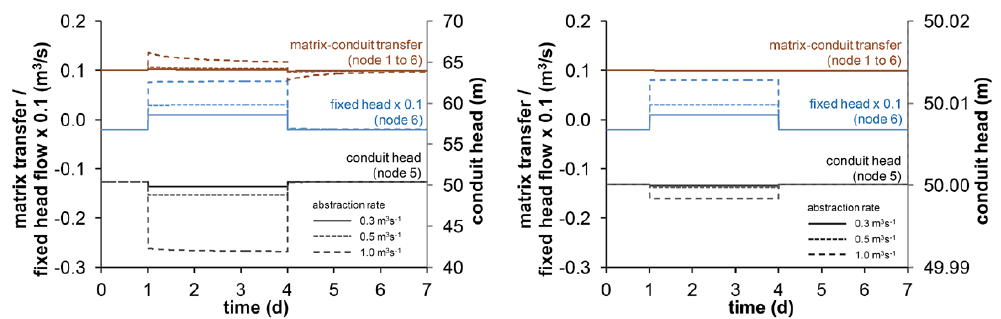
Fig. 6. Simulation results for the basic model (without CADS): conduit head at the pumping well, flow at the conduit constant-head boundary condition (here multiplied by 0.1) and matrix transfer for different pumping rates of 0.3, 0.5, and 1.0m 3 s − 1 respectively; left: conduit diameter = 0.5m; right: conduit diameter=2.5m (note that the scales for conduit heads differ in both